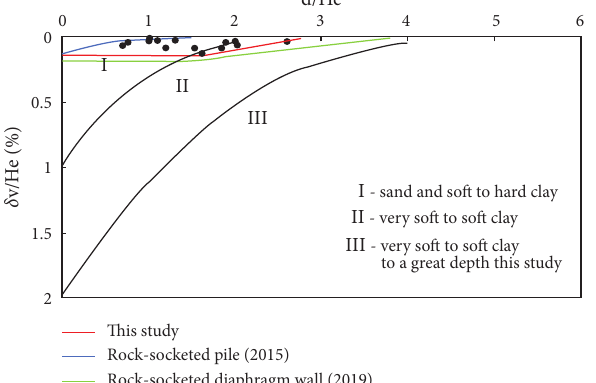
Figure 10: Observed building settlement profiles versus those predicted by empirical methods: the relationship between ( δ ( d / H ) . e